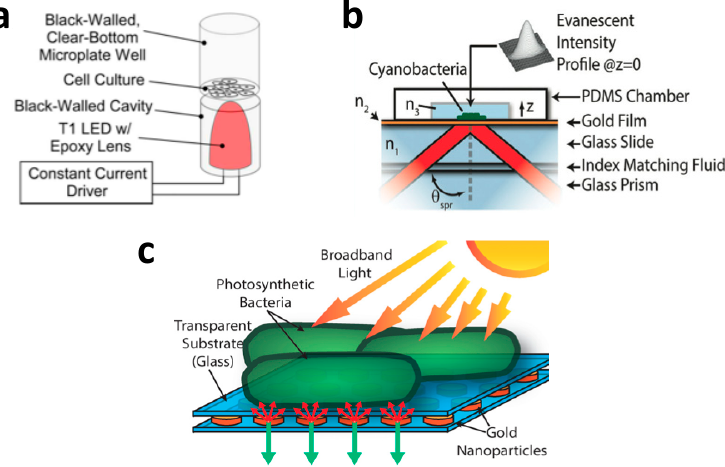
Figure 5. Light coupling mechanisms. ( a ) Direct illumination from a LED [37]. Reproduced with permission from Lab on a chip; published by Royal Society of Chemistry, 2012. ( b ) Surface plasmon illumination [55]. Cyanobacteria are placed on a gold film and light is coupled via a glass prism in the Kretschmann configuration; Reproduced with permission from Applied Physics Letter; published by American Institute of Physics, 2012. ( c ) Localized surface plasmon resonance (LSP) coupling [56]. Cyanobacteria are placed on an array of gold nanoparticles, which are designed to optically resonate near the absorption maxima of pigments to reflect useful light to these microorganisms. Reproduced with permission from Applied Physics Letter; published by American Institute of Physics, 2014.